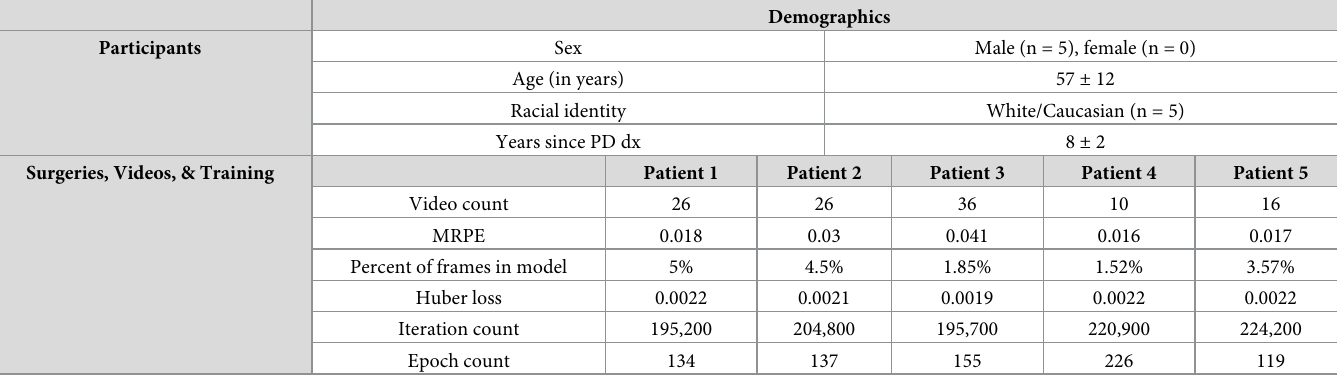
Table 2. Patient demographics and video/DeepLabCut descriptives.